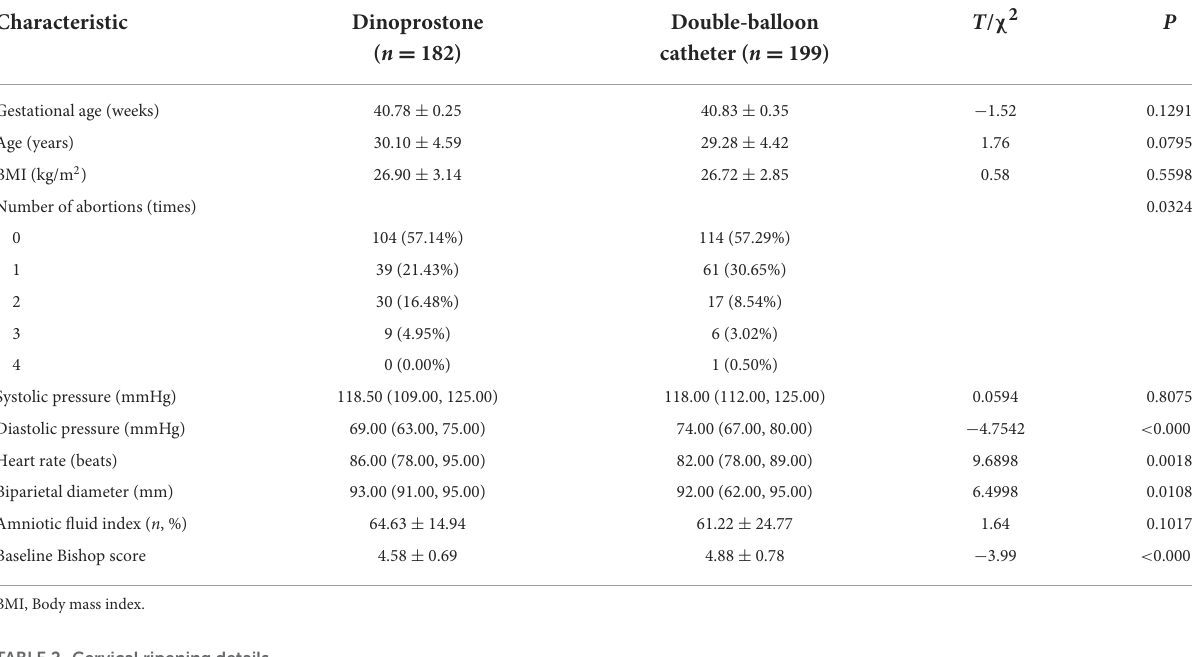
TABLE 1 Demographic and baseline characteristics.